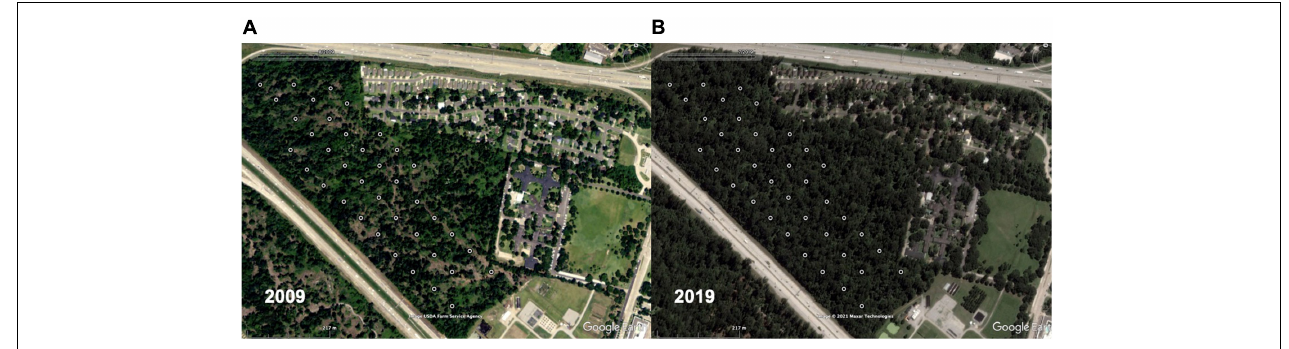
FIGURE 2 | Overhead map of the LSU AgCenter Botanic Gardens Forestry Research Area in 2009 (A) and 2019 (B)